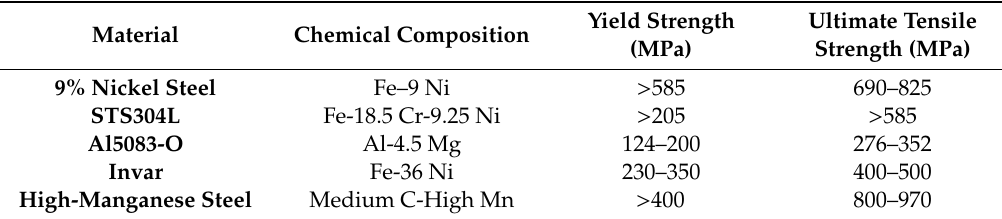
Table 1. Materials for cryogenic fuels listed in International Code of the Construction and Equipment of Ships Carrying Liquefied Gases in Bulk (IGC